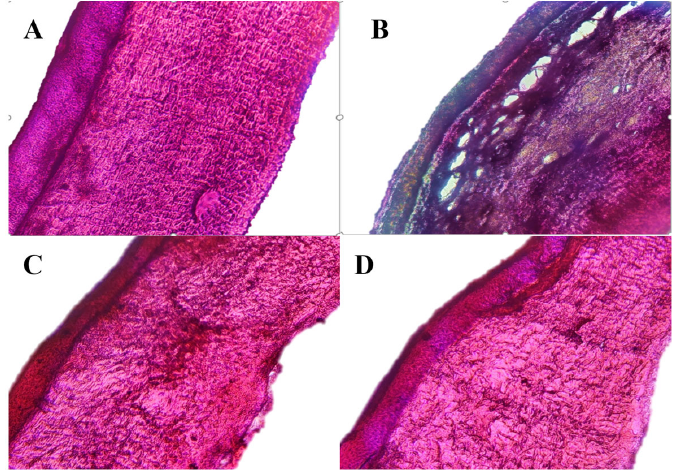
Figure 9. Microscopic images of the cornea exposed to ( A ) negative control (STF, pH 7.4); ( B ) positive control (IPA, 75% v/v ); ( C ) blank dual-responsive in situ gel and ( D ) NEB-loaded dual-responsive in situ gel.